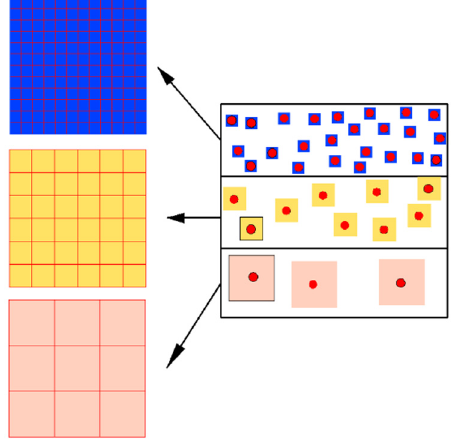
Figure 6. The schematic of the spatial geometric relationship of patches.